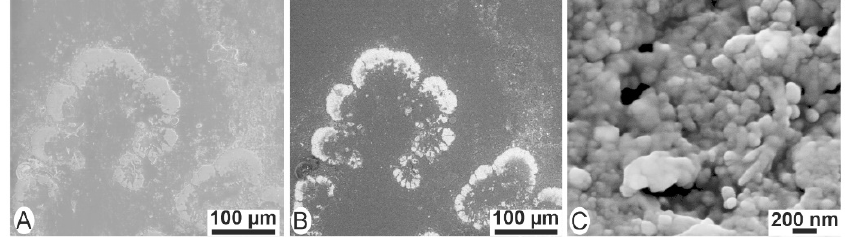
Figure 8. ( A ) SEM image in SE mode does not emphasize the heterogeneity of the branching deposit. ( B ) BSE mode clearly displays the contrast between mainly organic (black) and mainly mineralized (white) zones. ( C ) Nanogranular structure of the mineralized deposits.